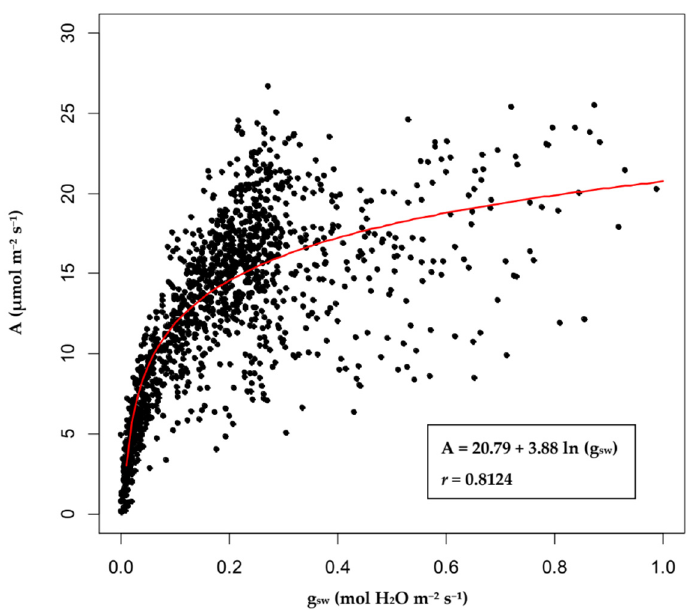
Figure 2. The logarithmic curve of stomatal conductance ( g sw ) and the net CO 2 assimilation rate ( A ) of Rosada tomatoes. The points in the figure are actual observations, and the red line is the fitted logarithmic curve.